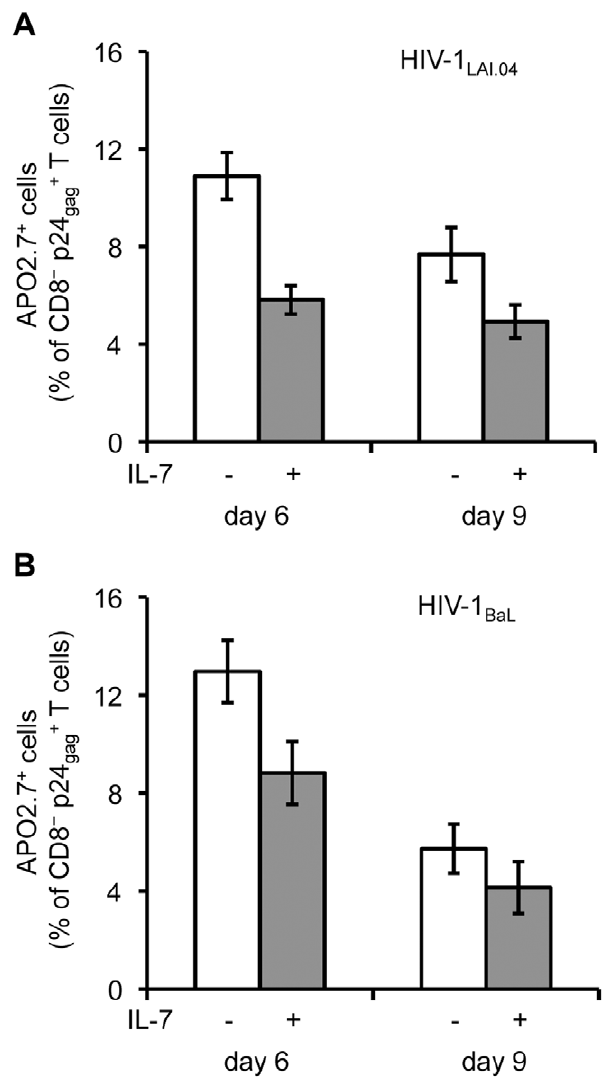
Figure 5. IL-7 decreases apoptosis of HIV-1-infected CD4 + T cells. Presented are the average fractions of HIV-1-infected CD4 + (CD8 2 p24 gag + ) T cells expressing the apoptotic marker APO2.7 isolated from donor-matched lymphoid tissue blocks infected with HIV-1 LAI.04 ( n =8) ( A ) or HIV-1 BaL ( n =5) ( B ) treated or not treated with IL-7 25 ng/mL (means 6 s.e.m.). The amount of APO2.7 + HIV-1-infected CD4 + T cells is expressed as a percentage of total CD8 2 p24 gag + T cells.